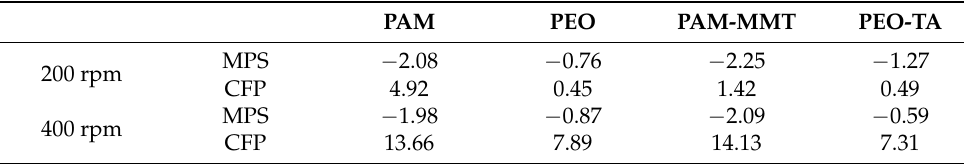
Table 2. Slopes of MPS decrease and CFP